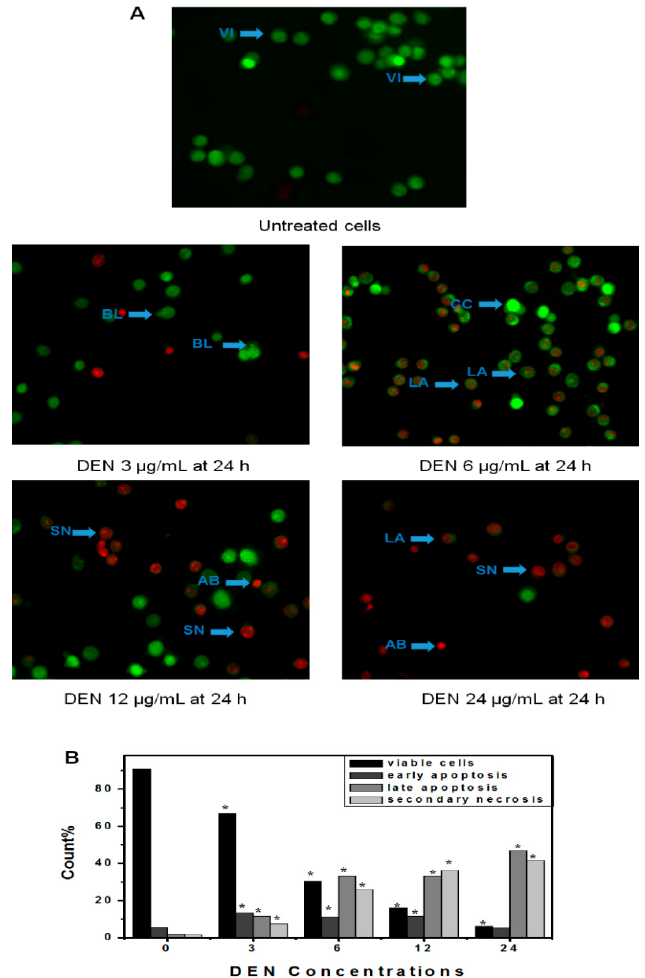
Figure 5. ( A ) Fluorescent micrographs of double-stained HT29 cells (acridine orange and propidium